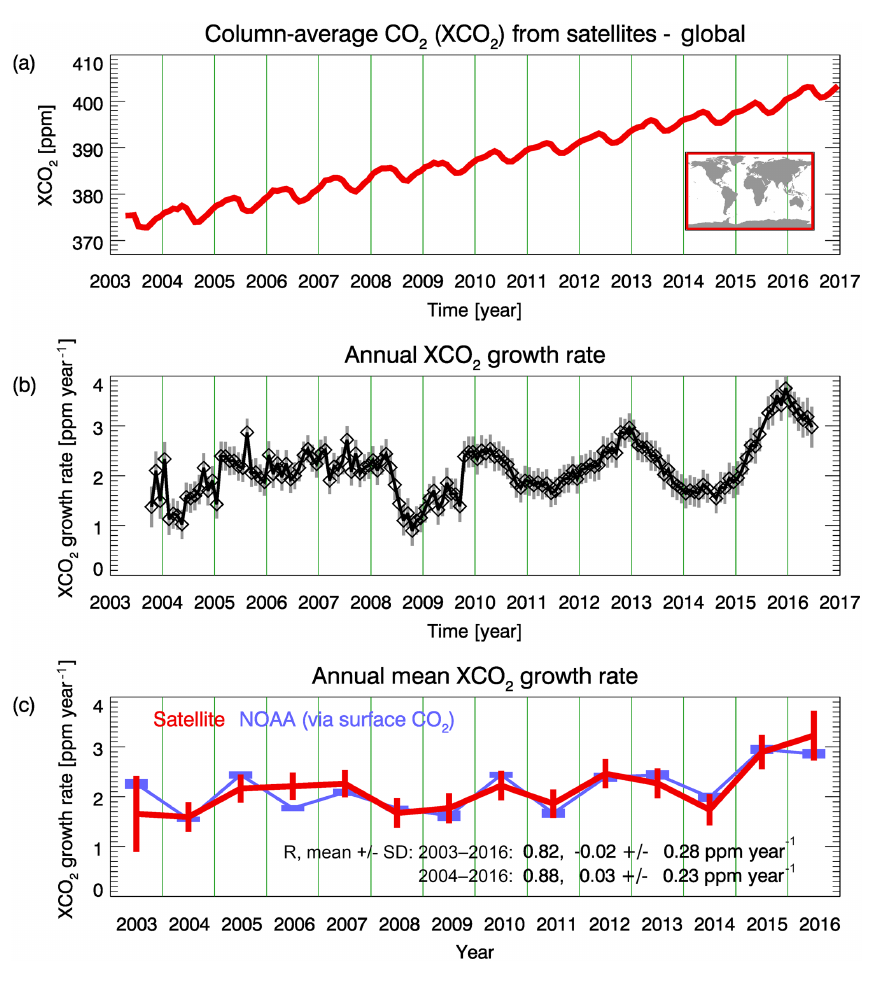
Figure 2. Atmospheric CO 2 and corresponding growth rates. (a) Monthly mean XCO 2 (red line) as obtained from averaging XCO 2 data product O4Mv3 globally for each month. (b) Monthly sampled annual CO 2 growth rates computed from the red curve shown in (a) including 1 σ uncertainty (grey vertical bars). (c) Annual mean growth rates computed from averaging the values shown in (b) including 1 σ error estimates (vertical bars) (the numerical values are listed in Table A1 of Appendix A). The NOAA annual mean global growth rate is also shown in (c) for comparison (in blue). Also listed in (c) is the linear correlation coefficient ( R ), the mean difference and the standard